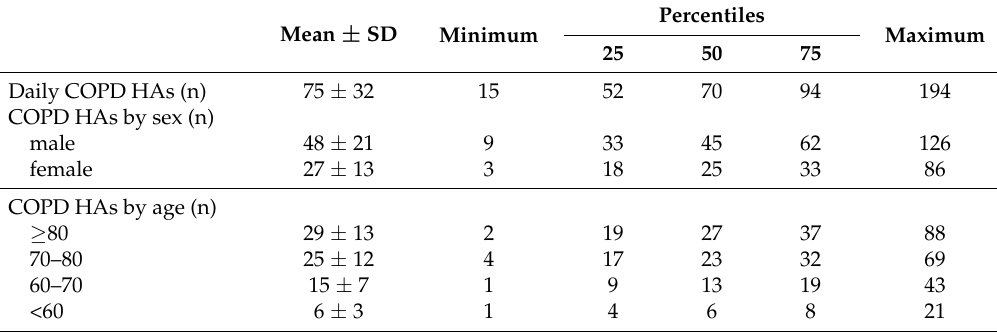
Table 1. Summary statistics of air pollutants, meteorological variables and COPD hospital admissions in urban areas of Chengdu, China